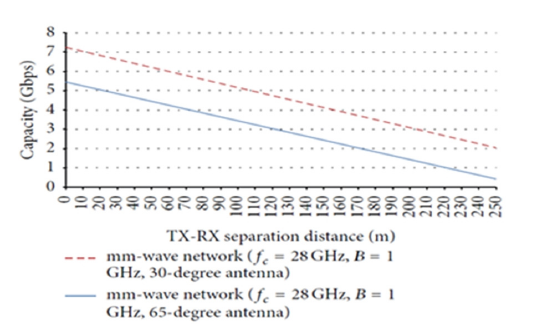
Figure 8. U.S. mm wave technology market from